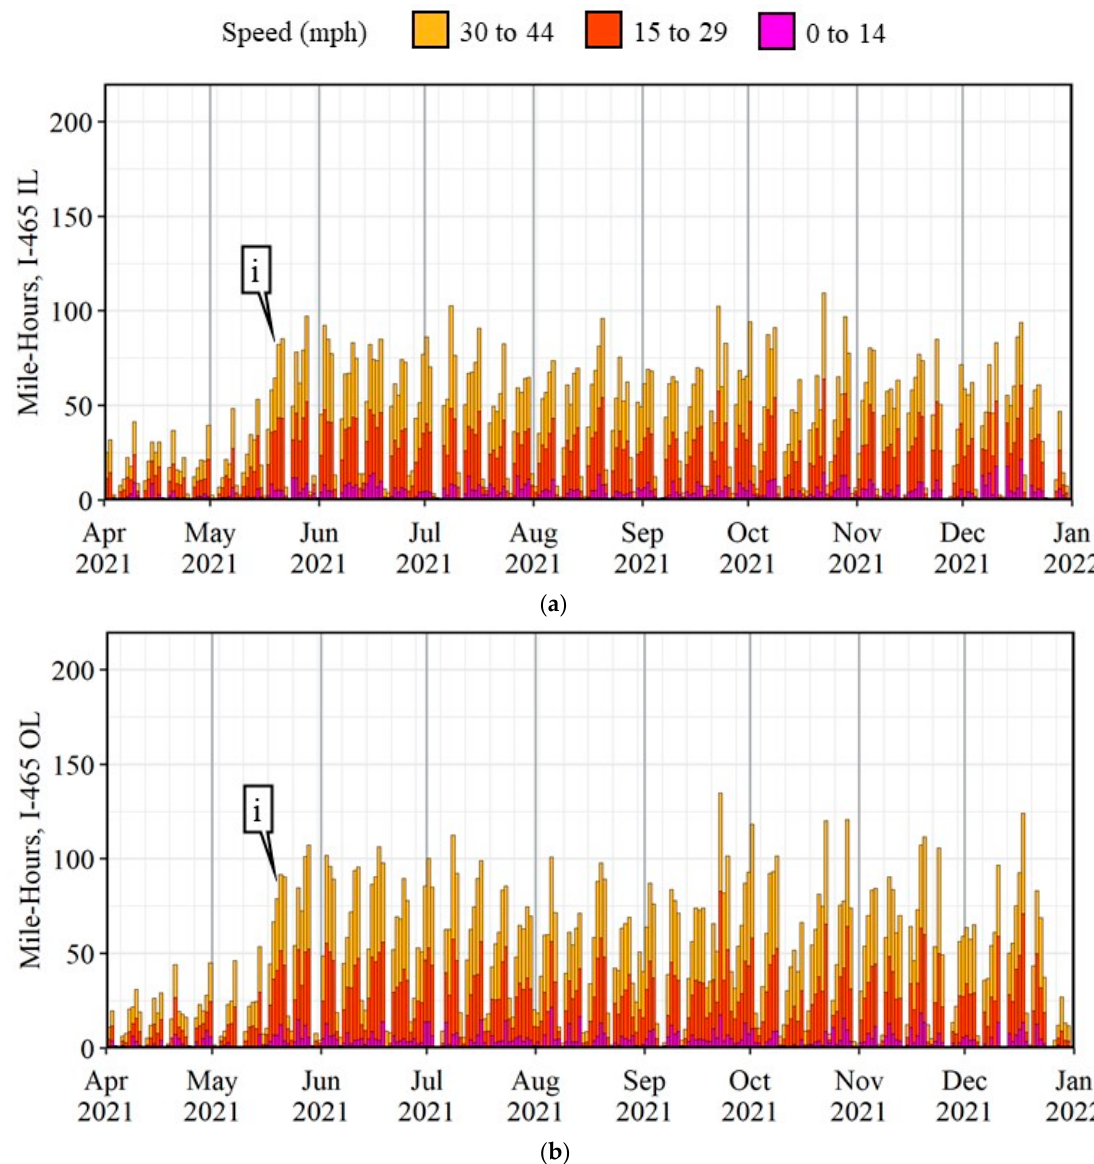
Figure 5. Daily mile–hours of congestion stacked by speed bins across I-465. ( a ) I-465 Inner Loop; ( b ) I-465 Outer Loop.